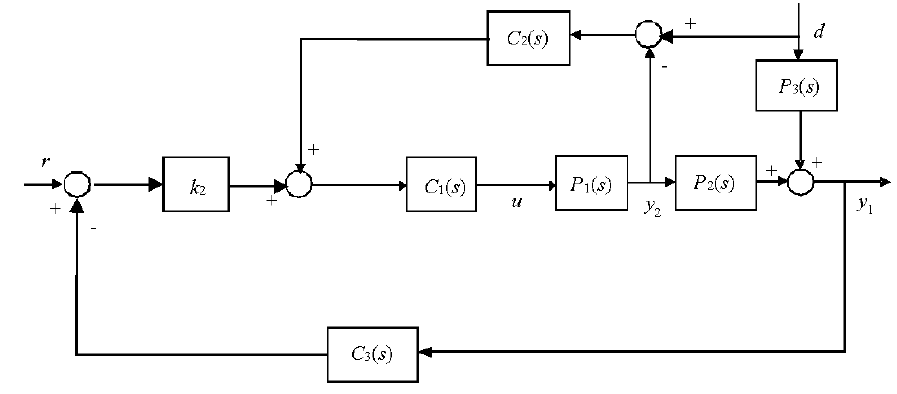
Figure 6. Block diagram of water level control system.